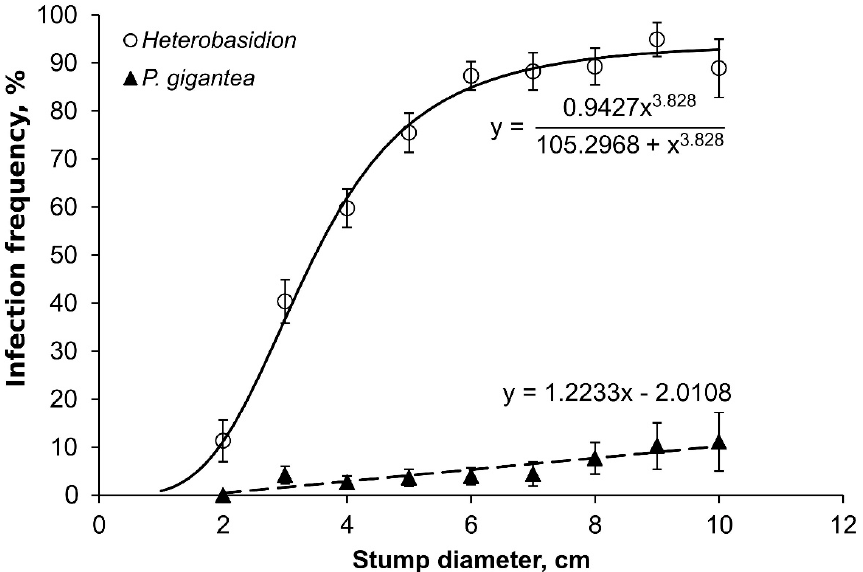
Figure 1. Heterobasidion and Phlebiopsis gigantea infection frequency of suppressed trees in relation to stump diameter. Heterobasidion r = 0.95; p < 0.001. P. gigantea r = 0.91, p < 0.001.